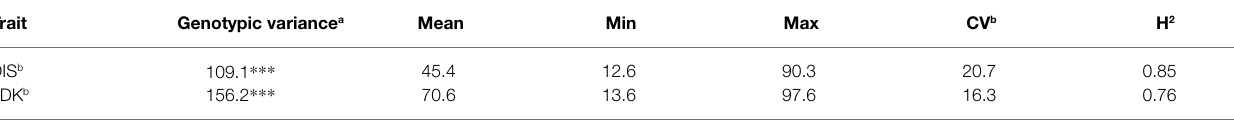
TABLE 1 | Phenotypic variation, variance estimates, and broad-sense heritability for studied FHB traits in the hard winter wheat panel of 257 breeding lines. Trait Genotypic variance a